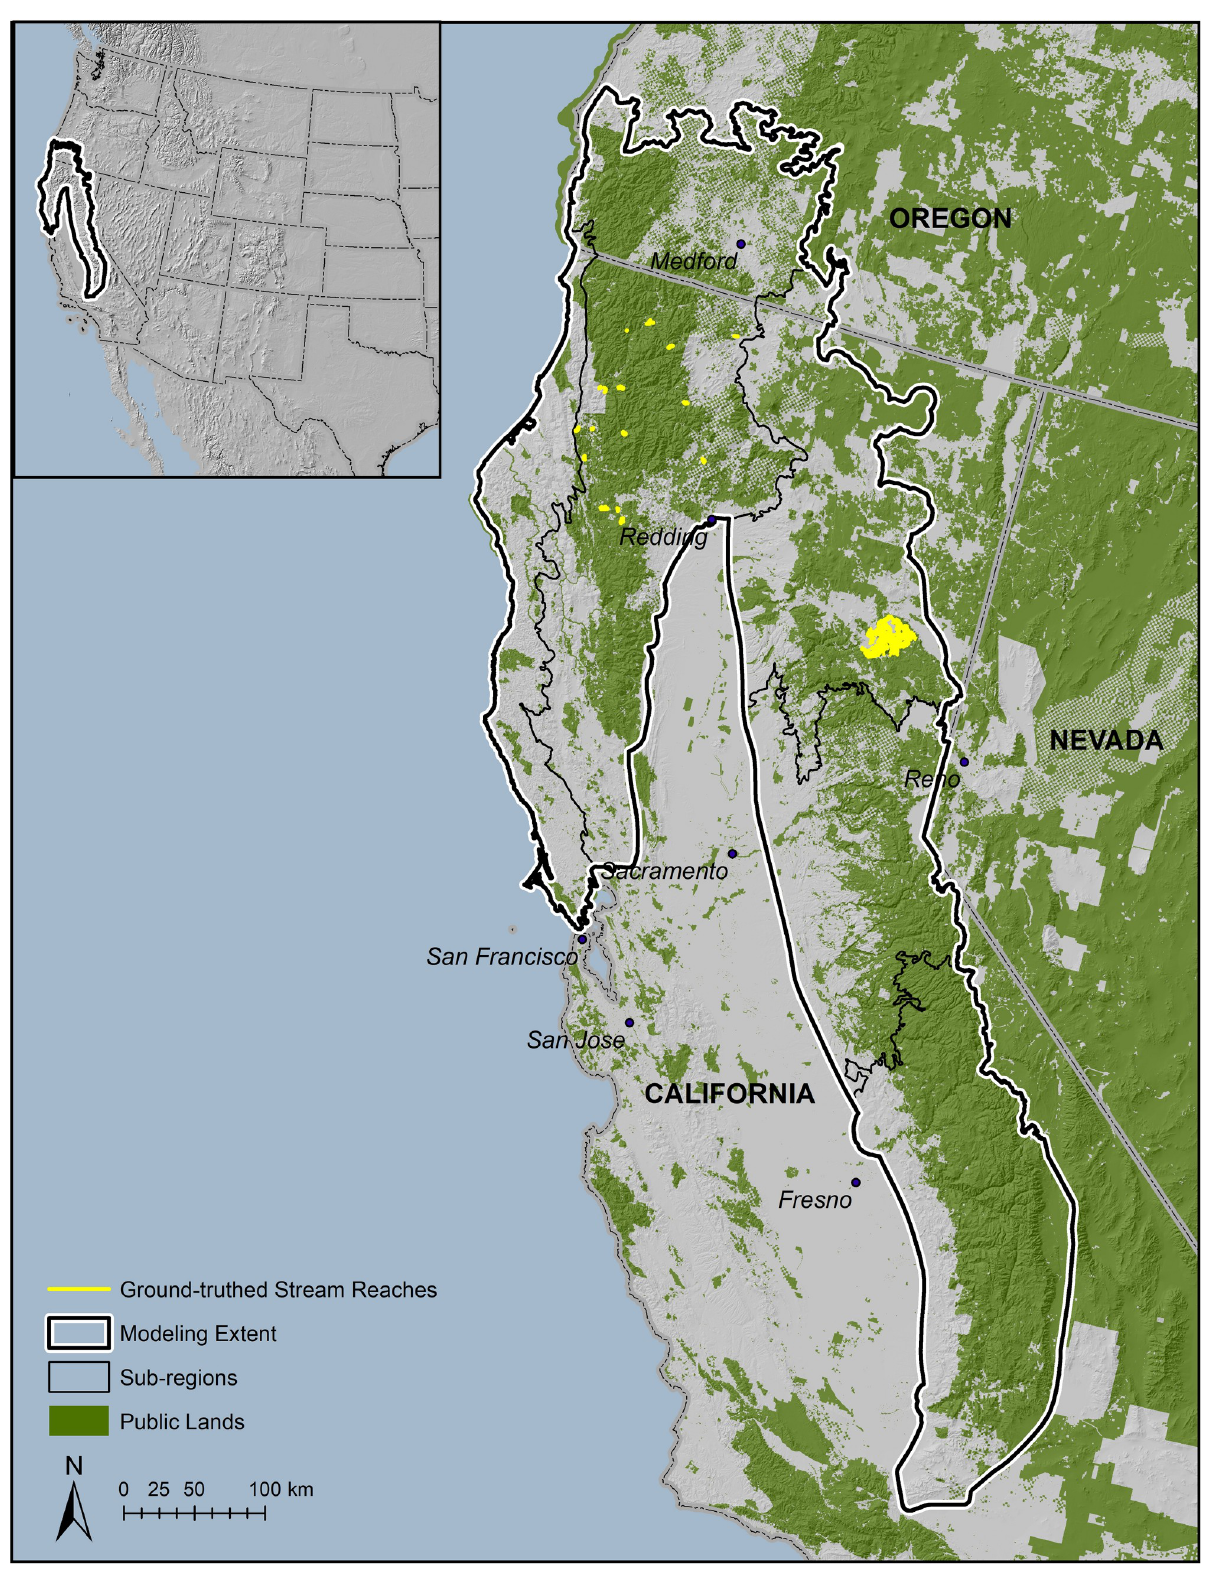
Fig 1. Study area showing modeling extent and five ecoregional subdivisions used for MaxEnt modeling of trespass cannabis grow sites, and subareas subject to ground-truthing. https://doi.org/10.1371/journal.pone.0256273.g001 PLOS ONE | https://doi.org/10.1371/journal.pone.0256273 September 1,